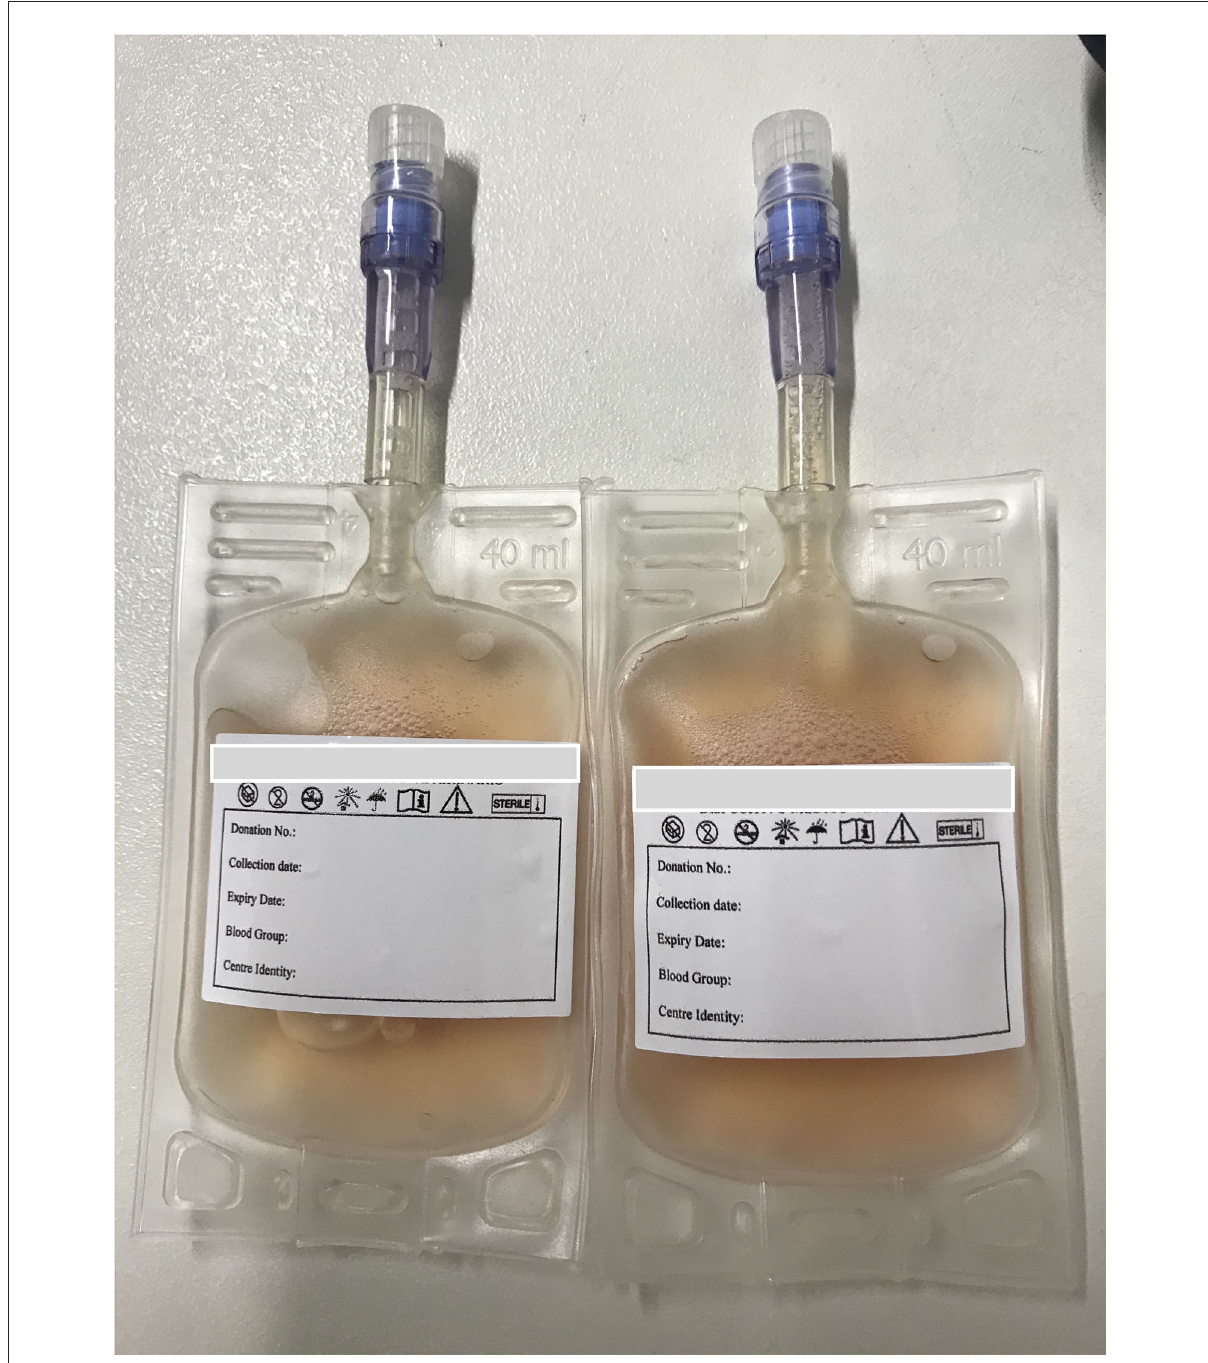
FIGURE1 Canine never-frozen liquid plasma ready to use in the volume desired and necessary for the patient’s need (property of REVLab, Veterinary Transfusion Research Laboratory, University of Milan,